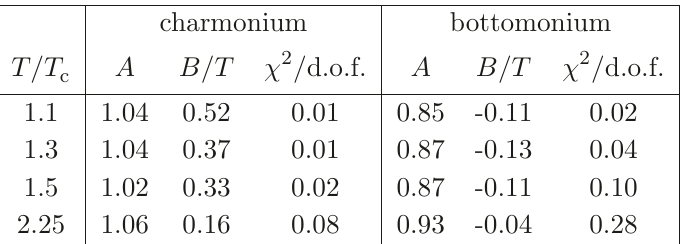
Table 3 . Best fit parameters according to eq. (6.1). The left set corresponds to charmonium, the right to bottomonium. In these fits the errors of the lattice results at different values of τT , which are dominated by systematic uncertainties, have been treated as independent of each